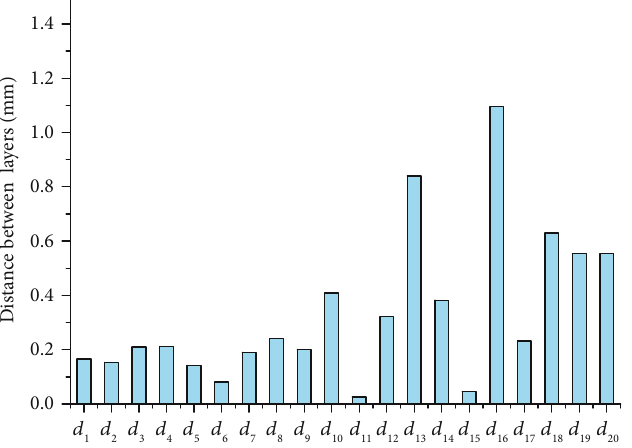
Figure 9: Cutting process of the laminate.